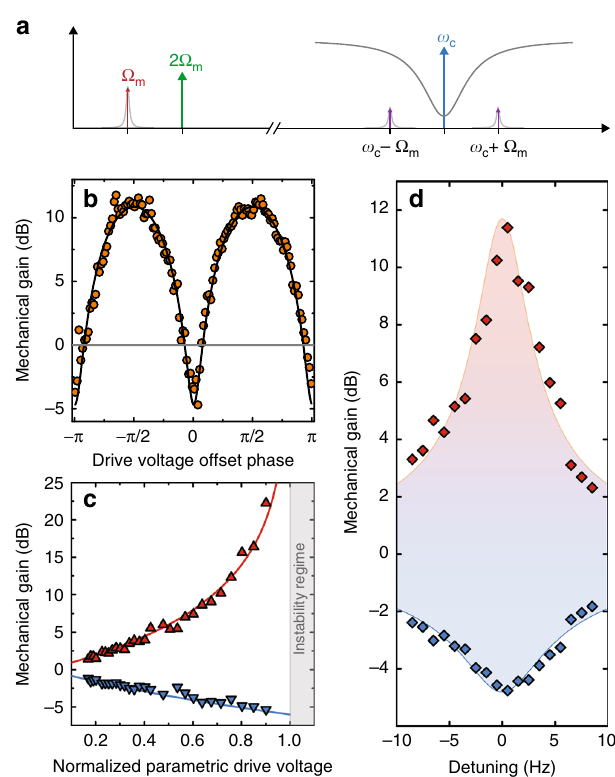
Fig. 2 Electromechanical detection of parametric, phase-sensitive mechanical amplitude ampli fi cation. a Experimental scheme. The mechanical oscillator is coherently driven by a combination of DC and alternating voltage with frequency Ω ~ Ω m , while the electrostatic spring constant is modulated with twice this frequency 2 Ω ~ 2 Ω m . Via the optomechanical coupling, the mechanical oscillations generate sidebands to a microwave pump tone sent to the cavity with frequency ω = ω c , which are used for homodyne detection of the mechanical amplitude. b Mechanical G amplitude gain 20 log vs. offset phase ϕ p between resonant drive and 10 p parametric modulation. When the phase is swept, the amplitude is oscillating between ampli fi cation or de-ampli fi cation with a periodicity of π . Circles show data and the line shows a fi t with the theoretical expression Eq. (2). c Maximum and minimum gain on resonance vs. parametric modulation strength. The maximum ( ϕ p = π ∕ 2) and minimum ( ϕ p = 0) gain values on resonance follow the theoretical curves (lines) up to a maximum gain of ~22 dB. For stronger parametric modulation amplitudes close to the instability threshold (indicated as vertical line), the gain in our experiments is limited by resonance frequency fl uctuations of the mechanical resonator. d Maximum and minimum gain vs. detuning from resonance. For a driving frequency slightly detuned from resonance, the maximum gain gets reduced compared to the resonant case. Points are extracted from phase-sweep curve fi ts. Lines show the corresponding theoretical curves and the shaded area contains all gain values achievable by changing ϕ p